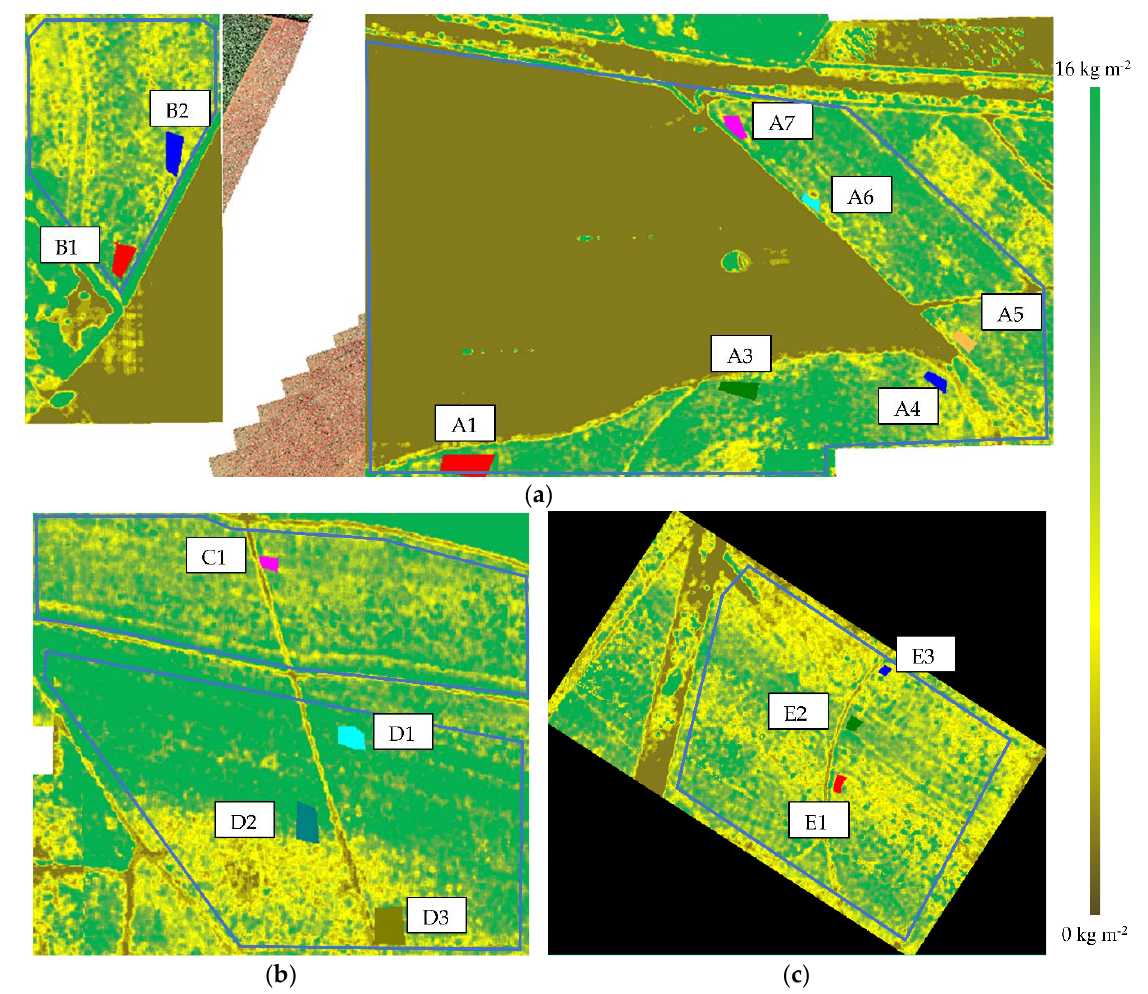
Figure 15. Estimated AGB maps. ( a ) Areas 1 and 2. ( b ) Areas 3 and 4. ( c ) Area 5. Figure 16 shows a comparison between measured and estimated AGB for the 15 sections indicated in Figure 15.